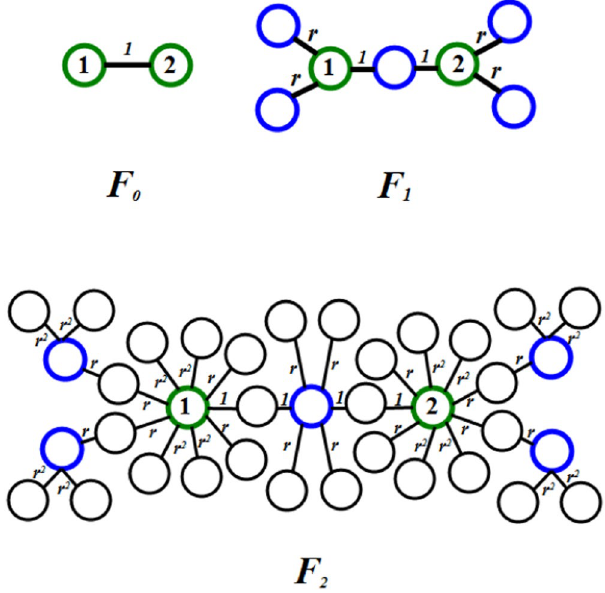
Figure 2. Iterative construction method for the weighted scale-free treelike networks F n ( m = 2) from n = 0 to n = 2, where blue nodes are generated at n = 1, black nodes are generated at n =